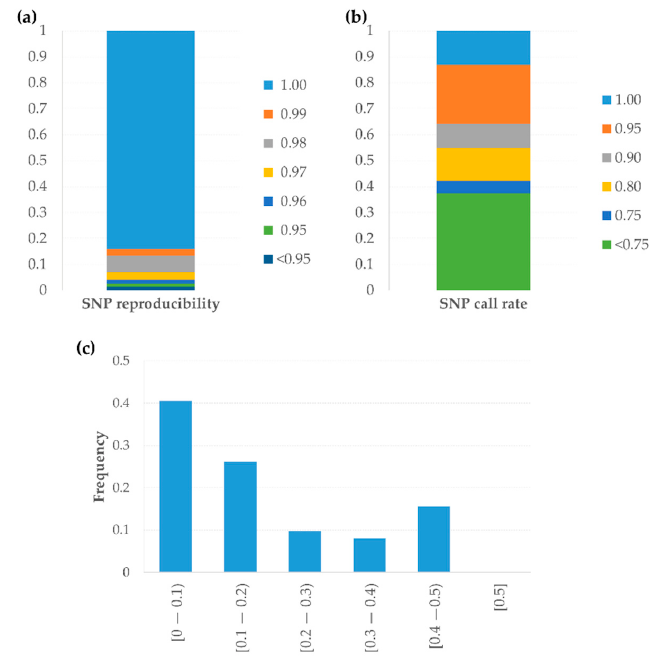
Figure 2. Distribution of Diversity Array Technology sequencing (DArT-seq) data for the quality parameters: ( a ) single nucleotide polymorphism ( SNP) data reproducibility, ( b ) SNP data call rate parameters: ( a ) single nucleotide polymorphism (SNP) data reproducibility, ( b ) SNP data call rate and and ( c ) SNP polymorphic information content distribution. ( c ) SNP polymorphic information content